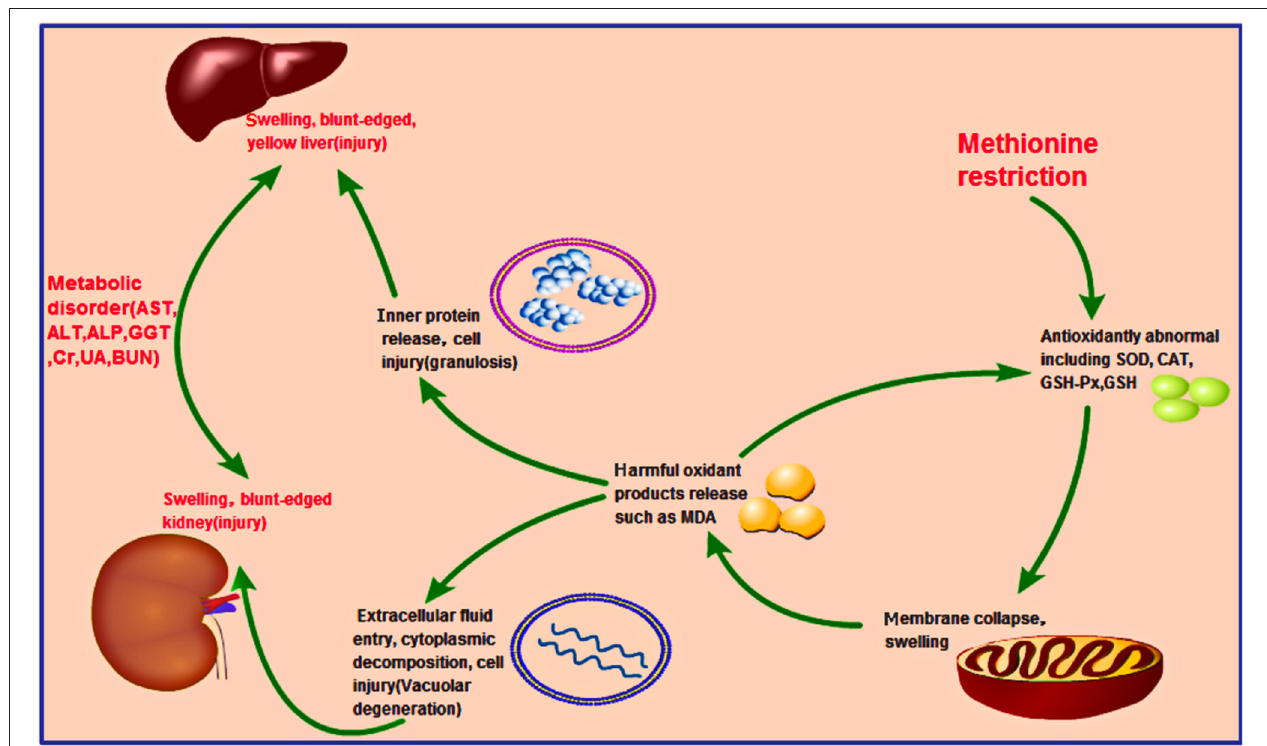
FIGURE 6 | Hypothesized pathology of methionine deficiency in the liver and kidney, reflecting induced oxidation stress. Methionine deficiency can decrease the activities of antioxidant enzymes such as SOD, CAT, GSH-Px, and GSH. The mitochondria, where many oxidation-related chemicals such as MDA exist, would be damaged, resulting in their release into the cytoplasm due to membrane collapse. Other organelles in the liver and kidney would then be harmed, releasing lots of proteins and changing the osmotic pressure, causing granulosis degeneration (liver) and vacuolar degeneration (kidney), respectively. Prolonged methionine deficiency could induce liver and kidney injury, finally leading to metabolic